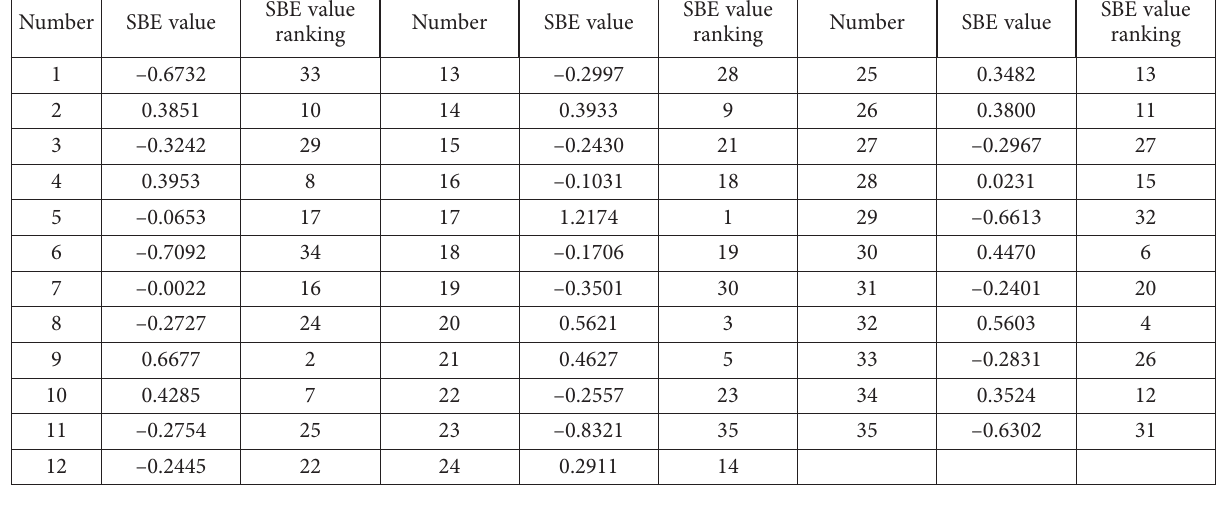
Table 2. SBE value and ranking of plant landscape in Jinlong lake wetland park